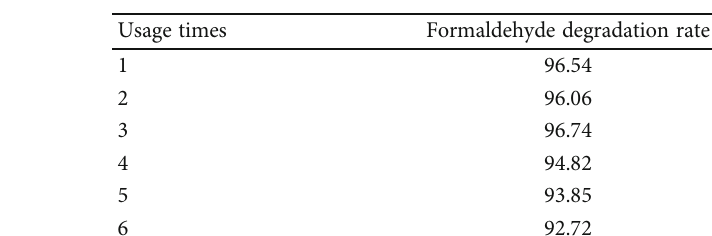
and CH NH Pb I . 2 3 3 3 Table 5: The relationship between TiO /AC usage times and 2 formaldehyde degradation